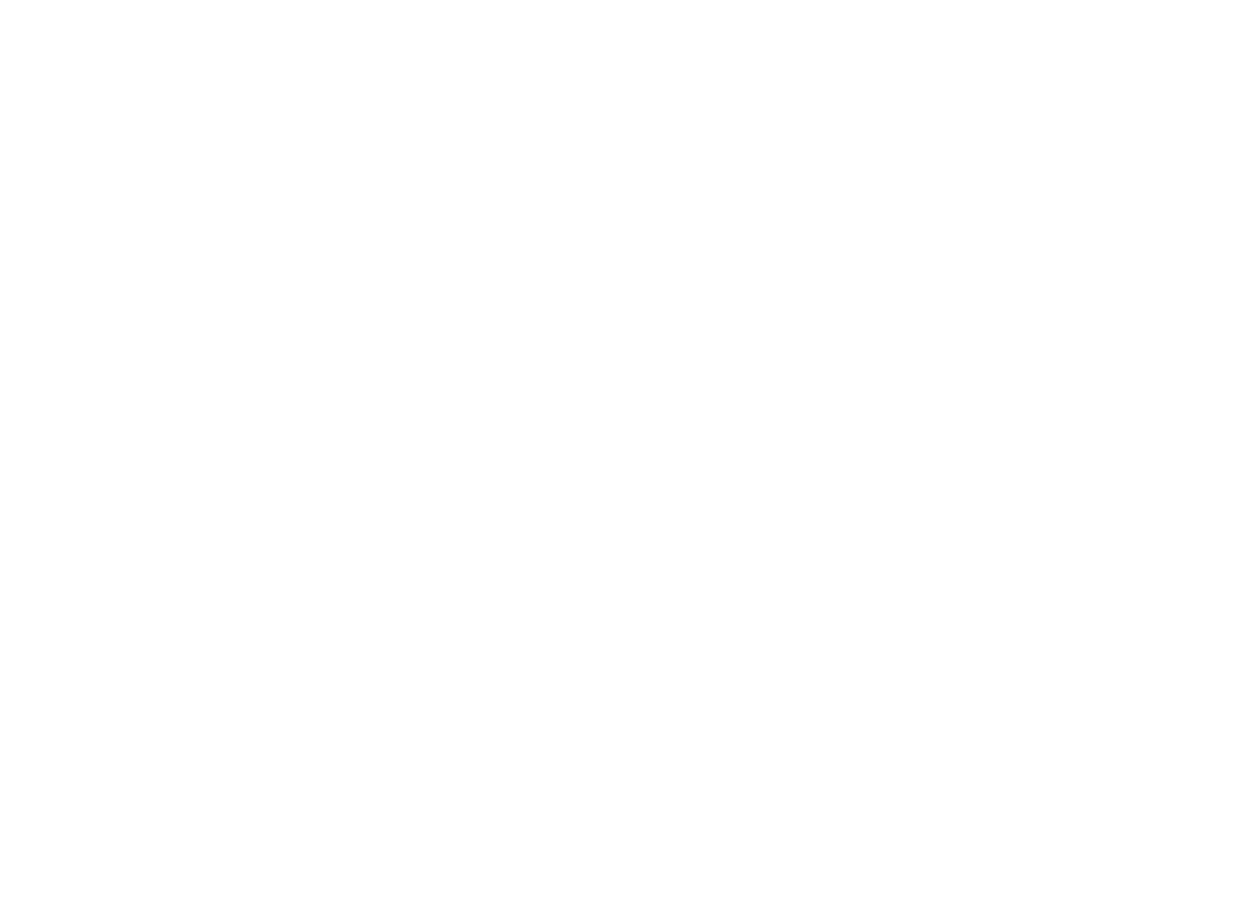
Frontiers in Pharmacology |